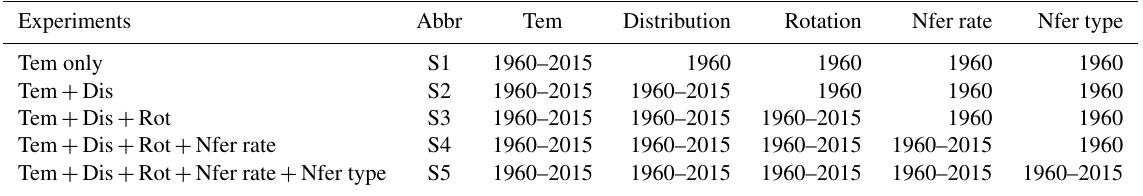
Table 1. Experiments designed in this study. Experiments Abbr Tem